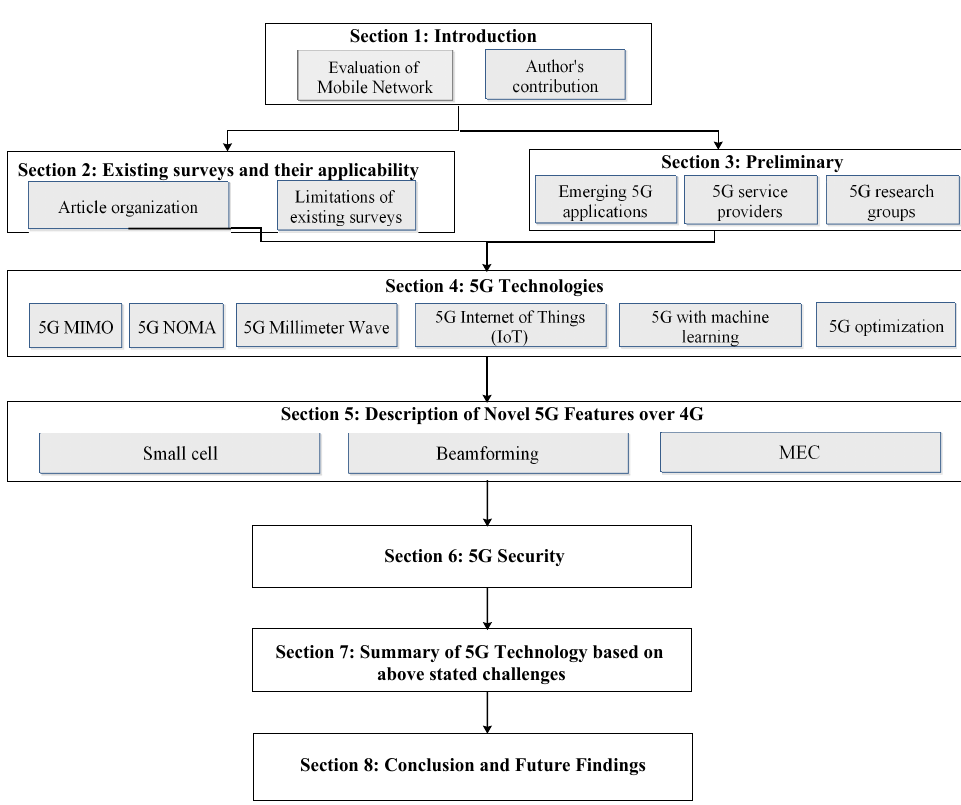
Figure 1. Systematic layout representation of